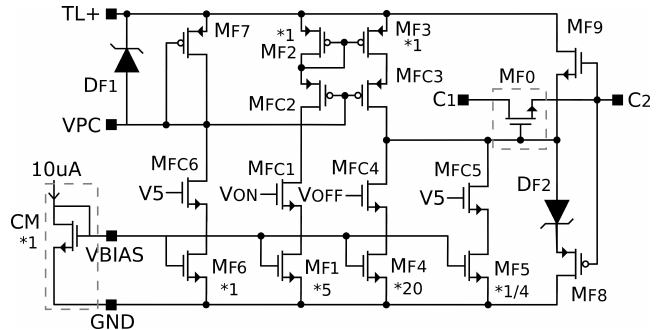
Figure 7. FS schematic.